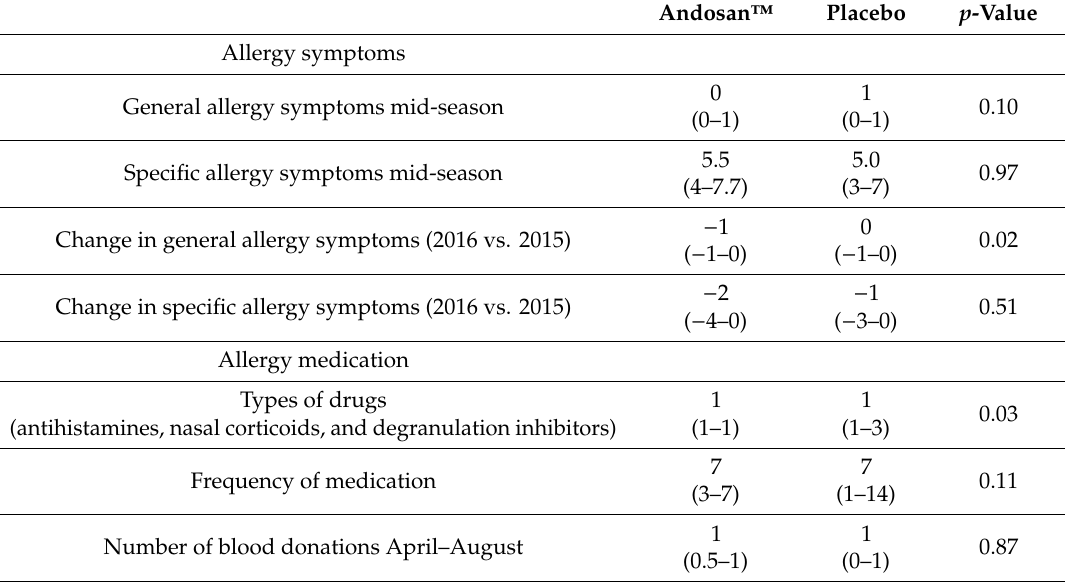
Table 2. Intervention data: